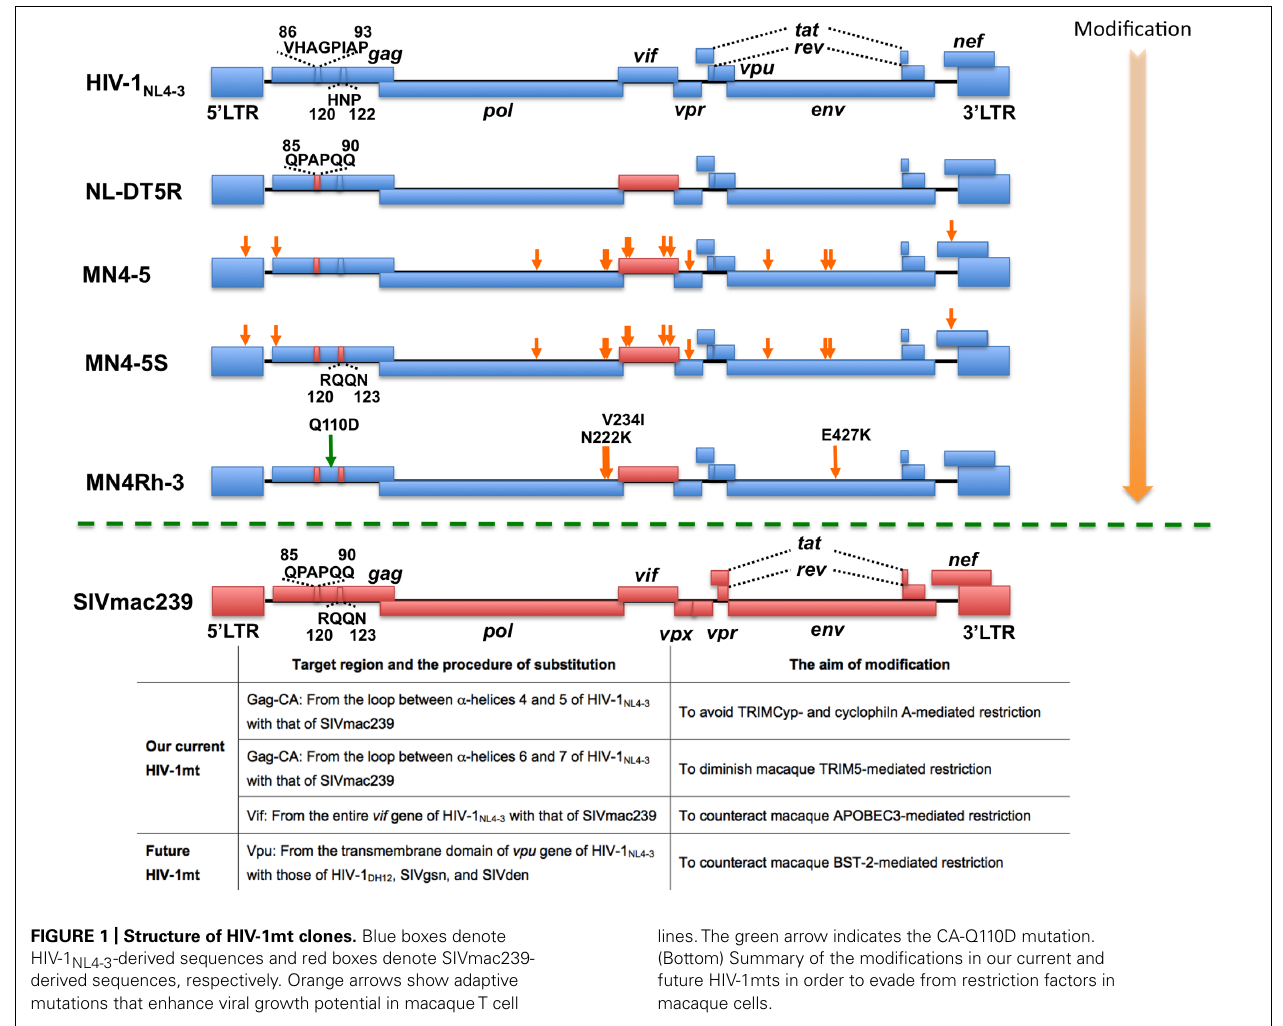
lines.The green arrow indicates the CA-Q110D mutation. (Bottom) Summary of the modifications in our current and future HIV-1mts in order to evade from restriction factors in macaque